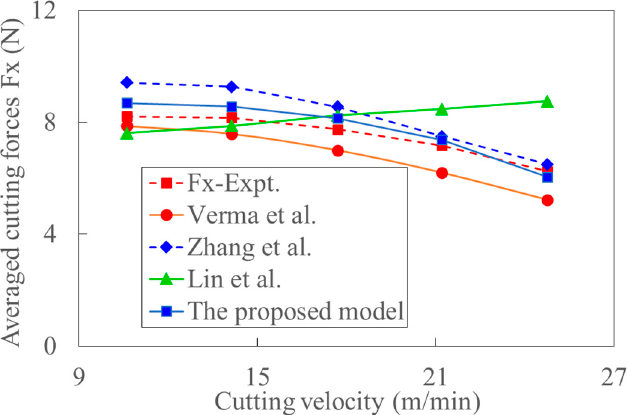
Figure 20. The comparison of predicted and experimental averaged cutting forces with increased cutting velocity (Feed rate: 50 mm/min, Cutting depth: 0.6 mm, Amplitude: 12 um).